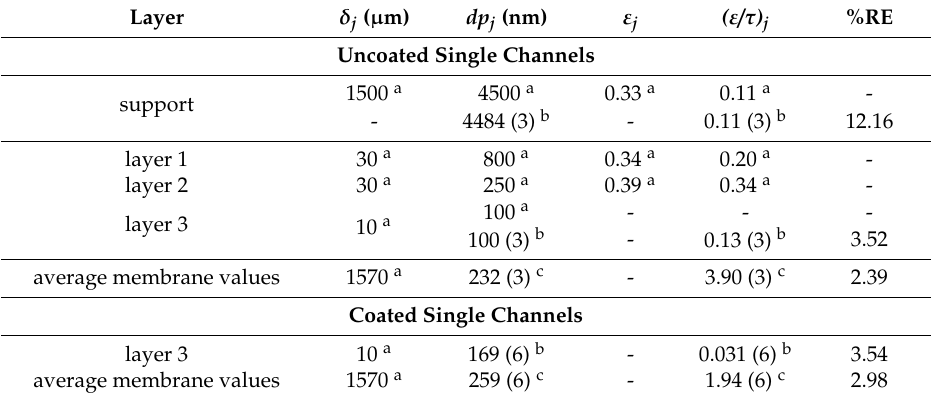
Table 1. Morphological parameters of single channels. Nominal values are compared with those obtained by gas permeation tests elaborated according to di ff erent procedures (the number of trials is reported in